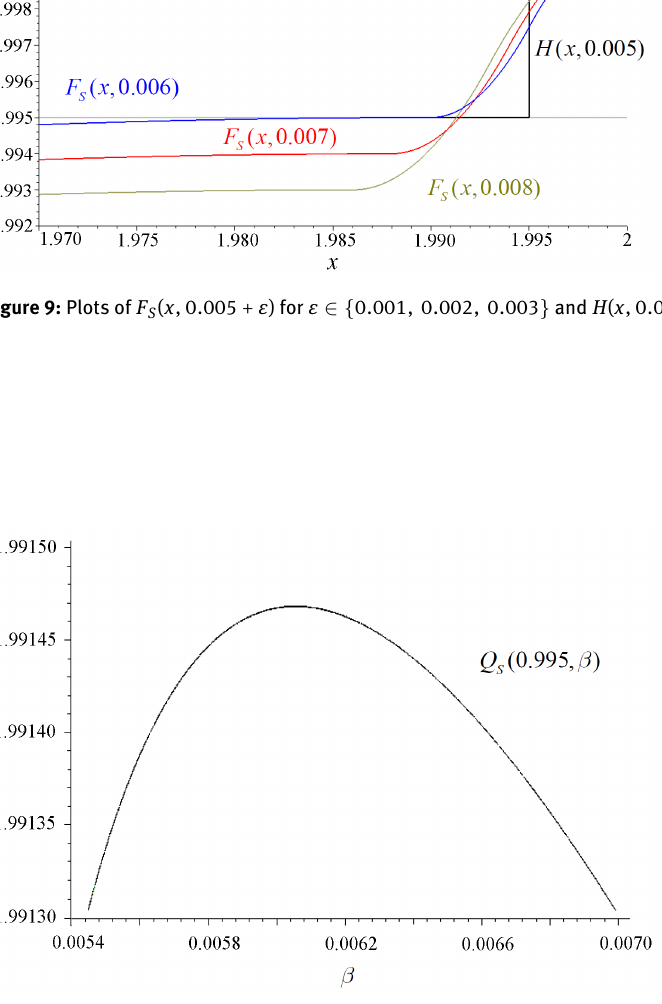
Figure 10: Plot of the parametrized quantile function Q S (0.995, β ) = F −1